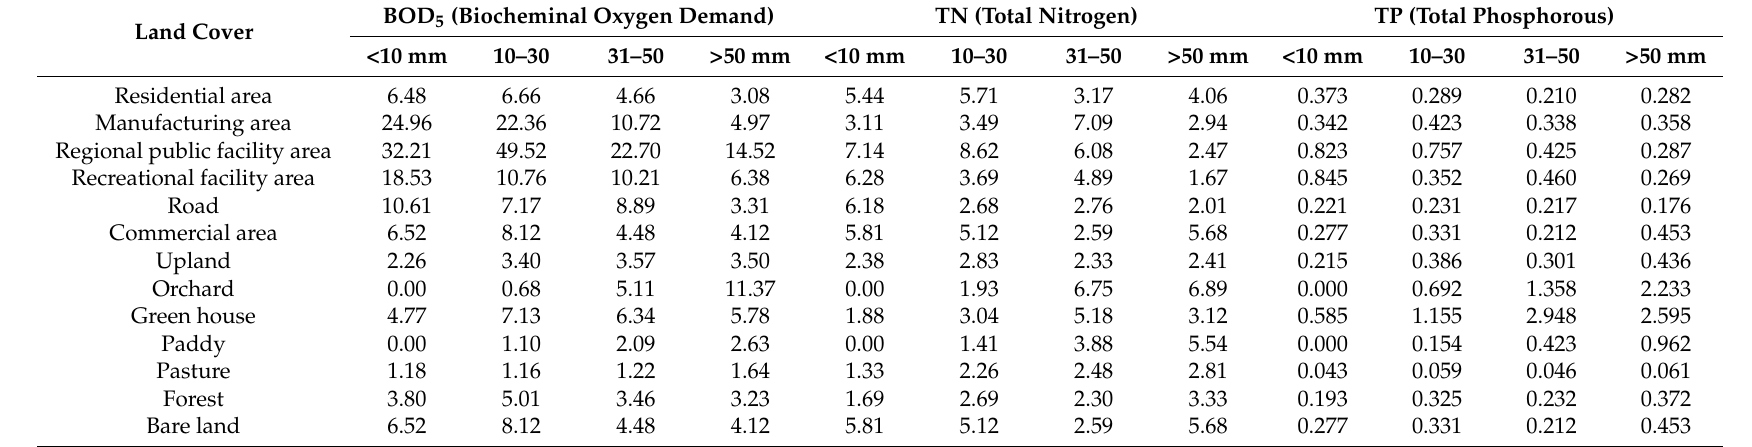
Table 1. Monitored event mean concentration (mg/L) of individual land cover for various rainfall